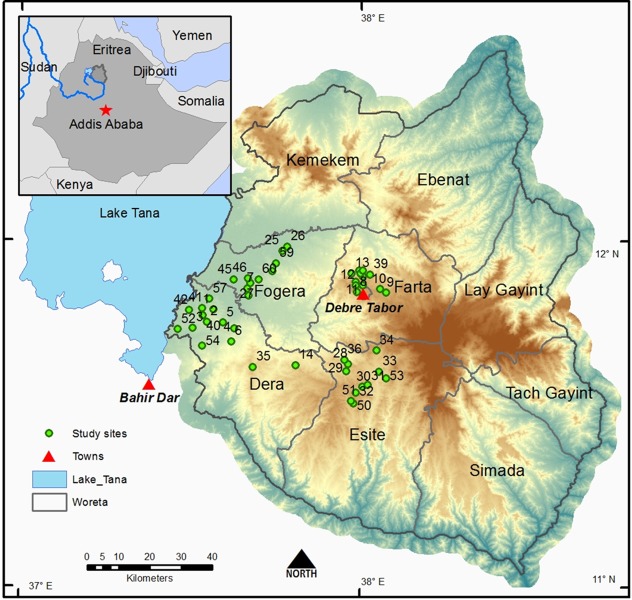
Map of study area in the South Gondar region of northern Ethiopia.Description: Church forests are scattered in the landscape and are separated by ~ 2 km with a matrix of agricultural land separating them. Named areas are Woredas or Districts [50]. Basemap images obtained form ESRI.